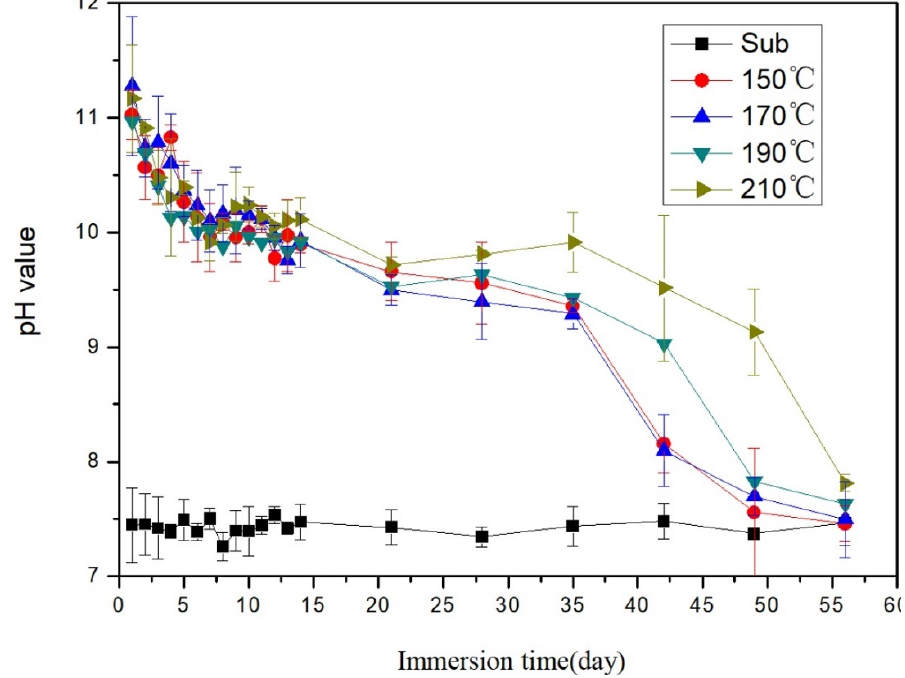
Figure 6. pH changes in Hank’s solution immersed with Mg-coated samples with different substrate temperatures.